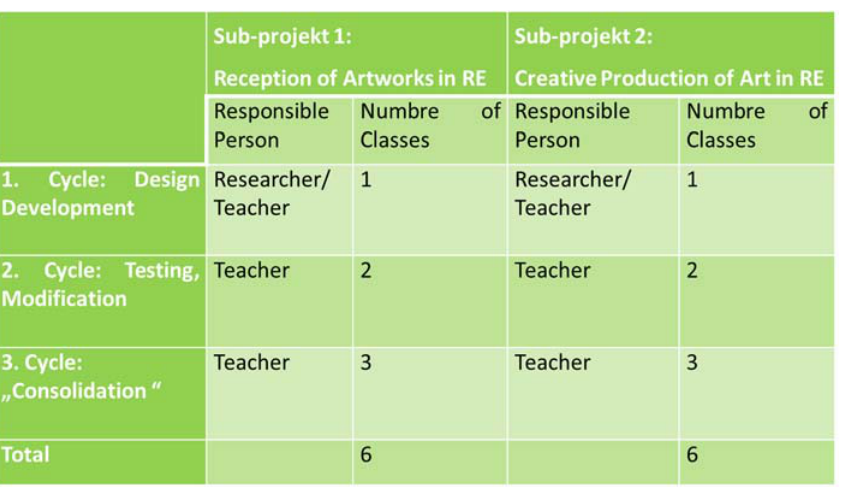
Figure 2. Sample and cycles of hekuru .